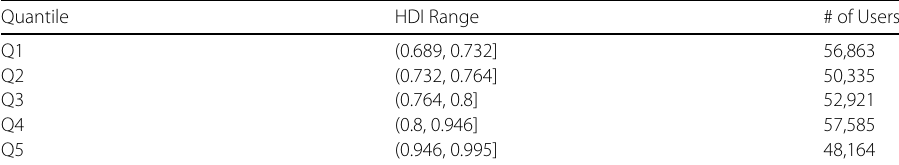
Table 2 Results of quantization of HDI values of users into quantiles Quantile HDI Range # of Users Q1 (0.689, 0.732] 56,863 Q2 (0.732, 0.764] 50,335 Q3 (0.764, 0.8] 52,921 Q4 (0.8, 0.946] 57,585 Q5 (0.946, 0.995]